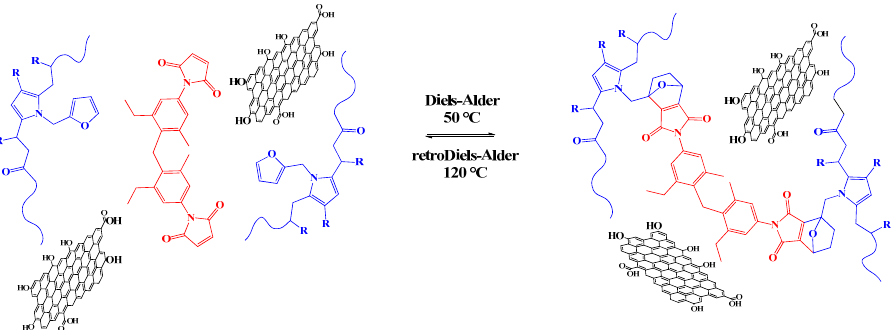
Figure 1. Schematic representation of the formation of the self-healing electrically-conductive nanocomposite based on the functionalized PK (blue), BISM (red) and the rGO (black) nanofiller .